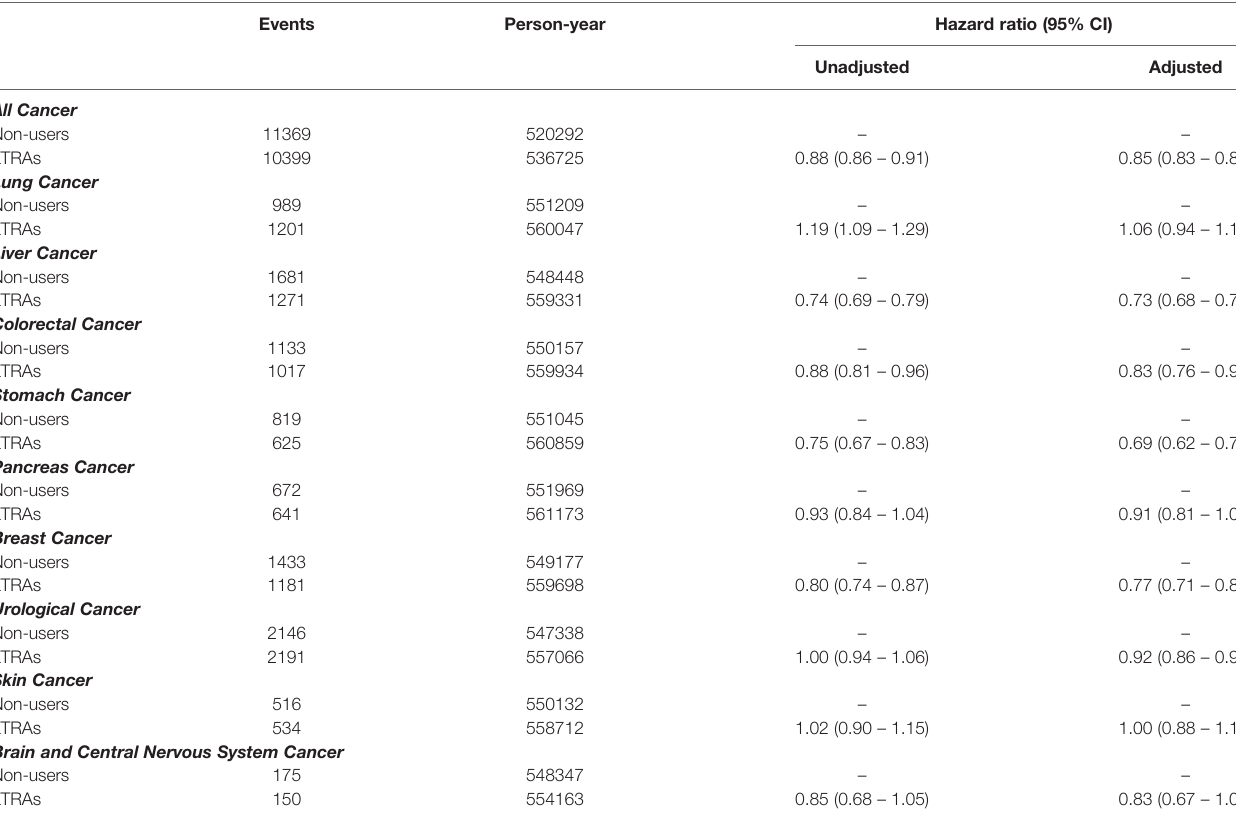
TABLE 2 | Hazard ratios for each cancer components.